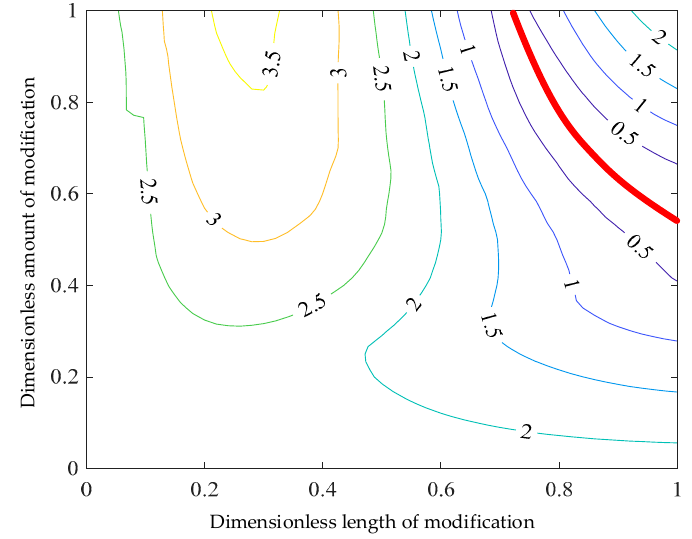
Figure 14. Brute global optimization of profile modification (unit: μ m).